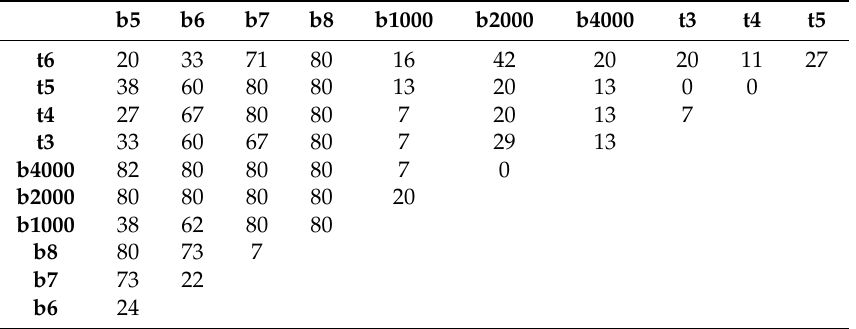
Table 5. Significant difference scores (%) between each tested method (laboratory study).